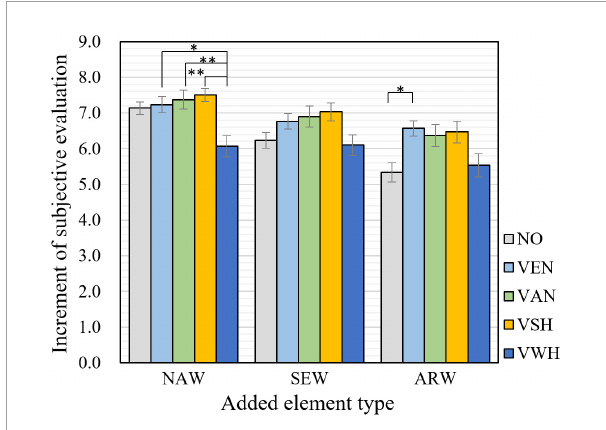
FIGURE8 Subjective evaluation of restoration after adding different visual elements in waterfront spaces. NAW, natural waterfront space; SEW, semi-natural-semi-artificial waterfront space; ARW, artificial waterfront space; VEN, visual elements of environment-nature; VAN, visual elements of animal-nature; VSH, visual elements of on-shore human activity; VWH, visual elements of on-water human activity; NO, no element added. (The error bars represent the standard errors on the averages: ± 1SE). Asterisks indicate statistically significant differences in mean scores (* p < 0.05; ** p <